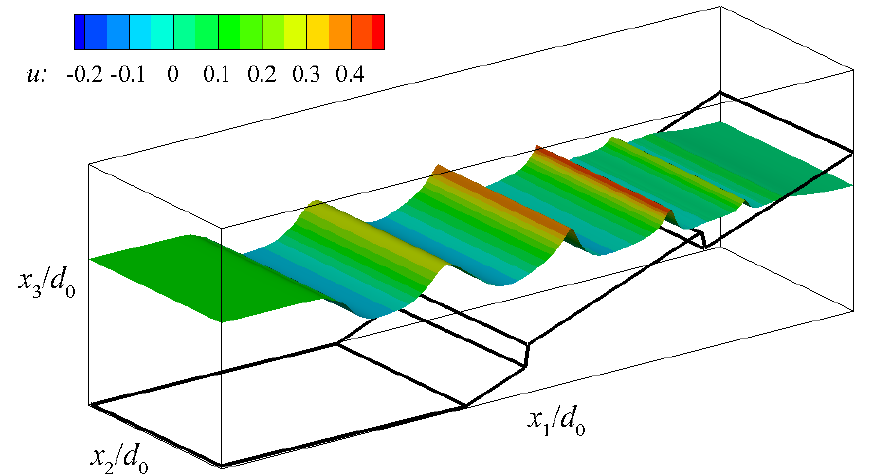
Figure 5. Instantaneous snapshot of streamwise velocity on the free surface of waves propagating over the CV field with n eq = 0.82 (Case 5). Note that the coordinate axes are not in scale for clarity of the exposition.